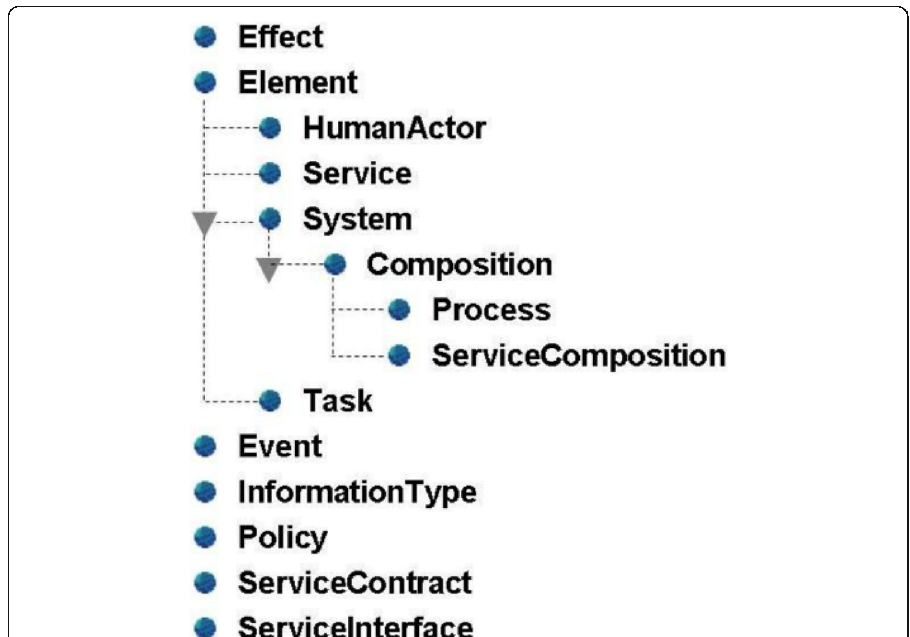
Fig. 4 SOA ontology – class hierarchy (The Open Group